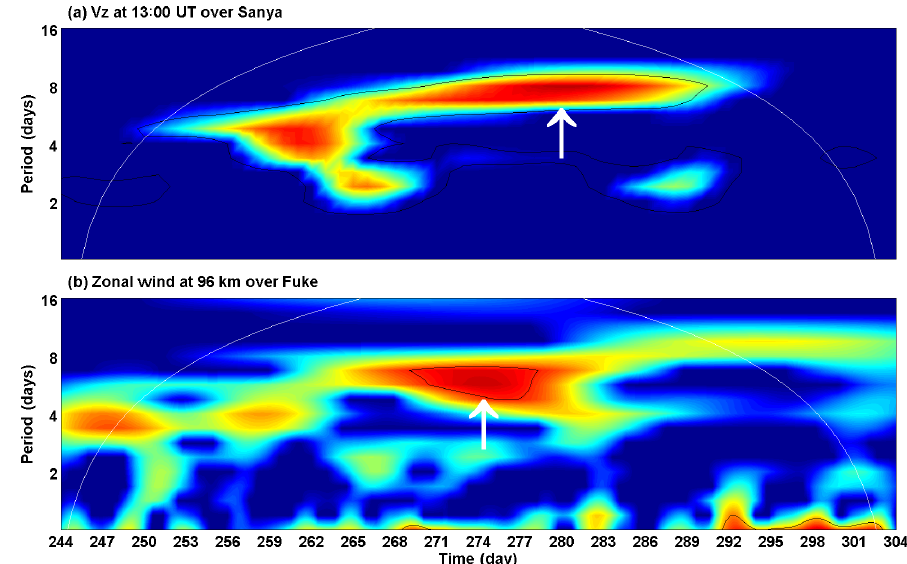
Figure 6. The comparison of the wavelet power spectra for the zonal wind at 96km at the MLT height over Fuke and the instant vertical drift at 3–6MHz at 13:00UT at the ionospheric height over Sanya from day 244 (1 September) to day 304 (31 October) in 2013. The white parabolic arch denotes the cone of the influence (COI). (a) The wavelet power spectrum of the vertical drift at 13:00UT. (b) The wavelet power spectrum of the zonal wind at 96km in the lower